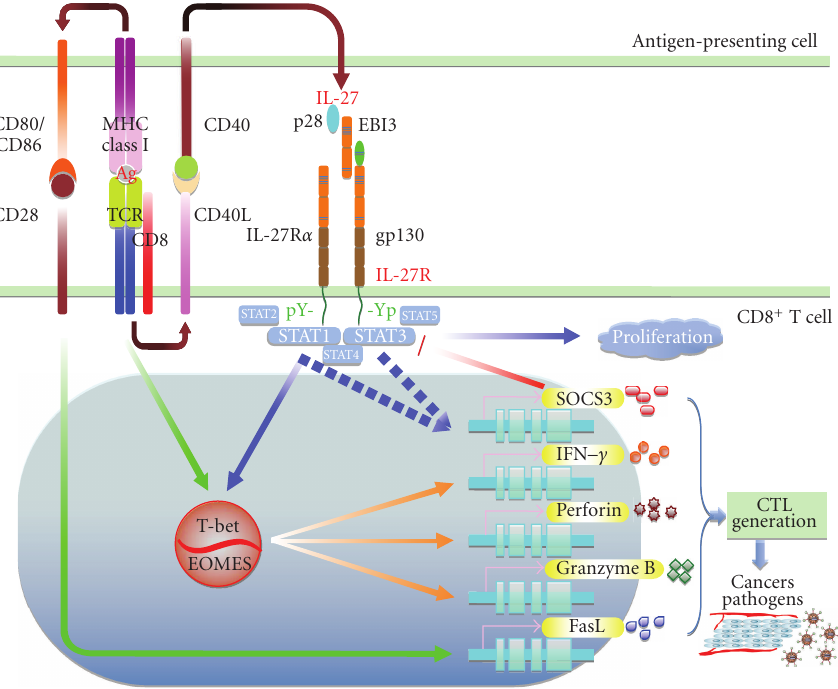
Figure 3: IL-27 plays a pivotal role in CD8 + T cell functions and generation of CTLs. In naive CD8 + T cells, IL-27 activates STAT1 and induces expression of T-bet and EOMES, which are critical transcriptional factors for generation of CTL by transcriptionally up-regulating IFN- γ and e ff ector molecules such as perforin and granzyme B. IL-27 also induces not only proliferation but also SOCS3 expression to limit the excessive proliferation mediated through gp130 of